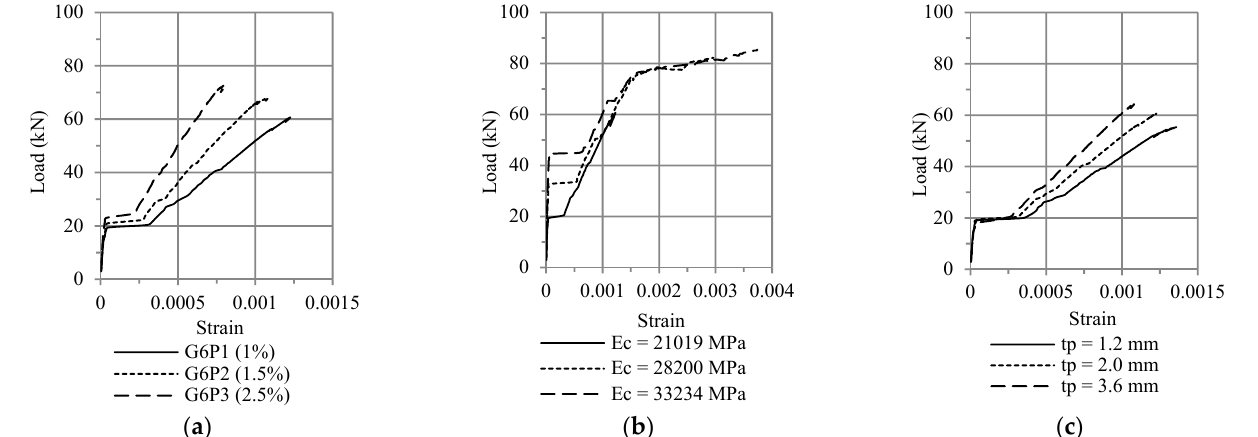
Figure 15. Effect of ( a ) ratio of tensile reinforcement, ( b ) the elastic modulus of the concrete, and ( c ) plate thickness on the strain of tensile reinforcement using ATENA.